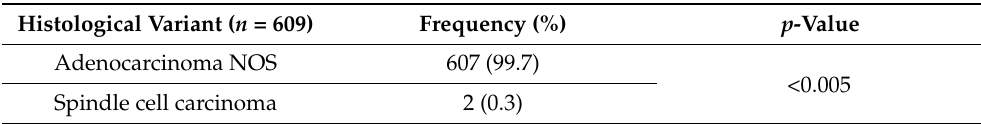
Table 3. Histological types of 609 patients with parathyroid cancer from the Surveillance, Epidemiol- ogy, and End Results (SEER) database, 1975–2016.